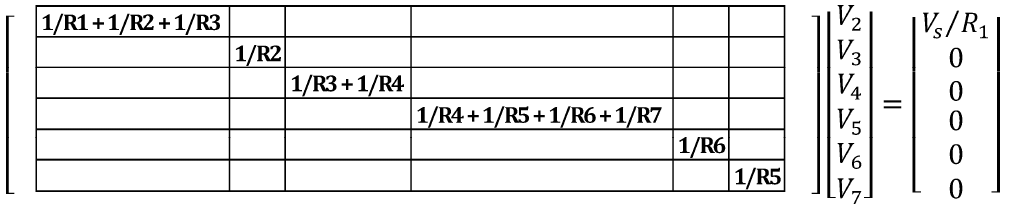
Figure 15. Diagonal elements of conductance matrix for example case.